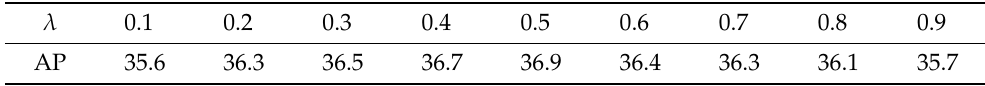
Table 5. Experimental results using different λ values.